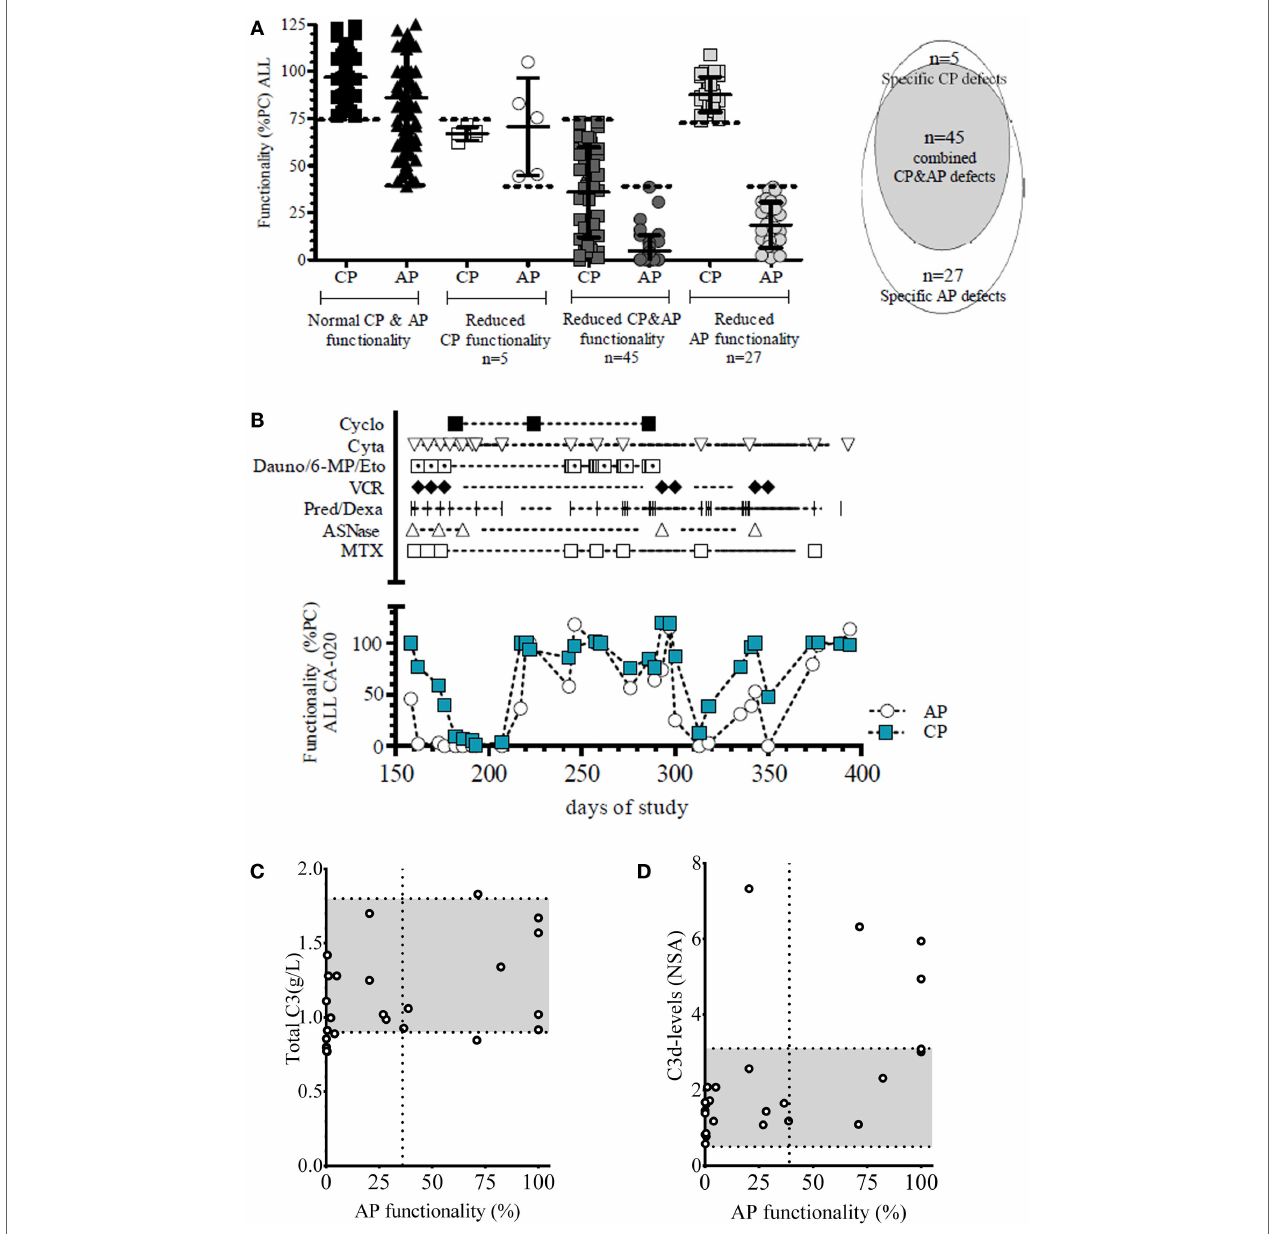
FigUre 5 | Temporal effect of all-11 protocol on complement functionality . (a) Functionality of the complement system of all patients treated according to the ALL-11 ( n = 5). The dotted line depicts the lower limit of functionality for CP functionality ( < 75%) and AP functionality ( < 40%) as determined for the WIELISA assay. In total, 77 time points showed a reduction in complement functionality in these ALL patients: 5 time points specific for the CP activity, 27 specific for the AP, and 45 specific for both the CP and AP activities. Functionality is depicted as percentage of a positive control (%PC). (B) Representative figure of one patient with ALL showing the different treatment compounds with the respective effect on the functionality of the complement system in a longitudinal setting (Cyclo: cyclofosfamide, Cyta: cytarabine, Dauno/6-MP/Eto: Daunorubicin/6-mercaptopurine/etoposide, VCR: vincristine, Pred/Dexa: prednisone/dexamethasone, ASNase: asparaginase, MTX: methotrexate). Functionality is depicted as percentage of a positive control (%PC). (c) Total C3 was measured and correlated to the AP functionality. Normal range for total C3 levels (0.9–1.8 g/L) is depicted in gray. (D) Complement activation product C3d was measured and correlated to AP activity. C3d levels are compared to fully activated normal serum aged for 1 week (NSA), normal ranges of C3d levels (0.5–3.1) are depicted in